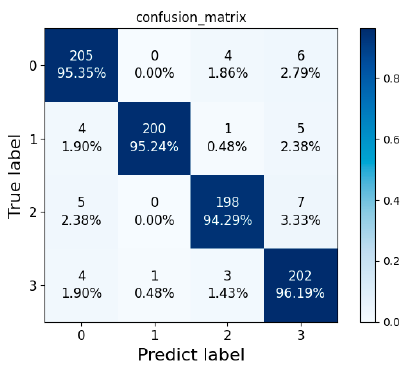
Figure 19. Classification model proposed in this paper .